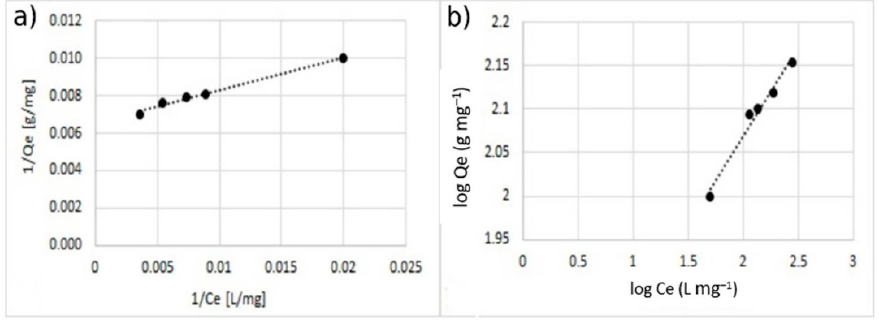
Figure 12. Adsorption isotherm for adsorption of Cu 2+ using MA with 5% w/w of the coating. ( a ) Langmuir model and ( b ) Freundlich model.